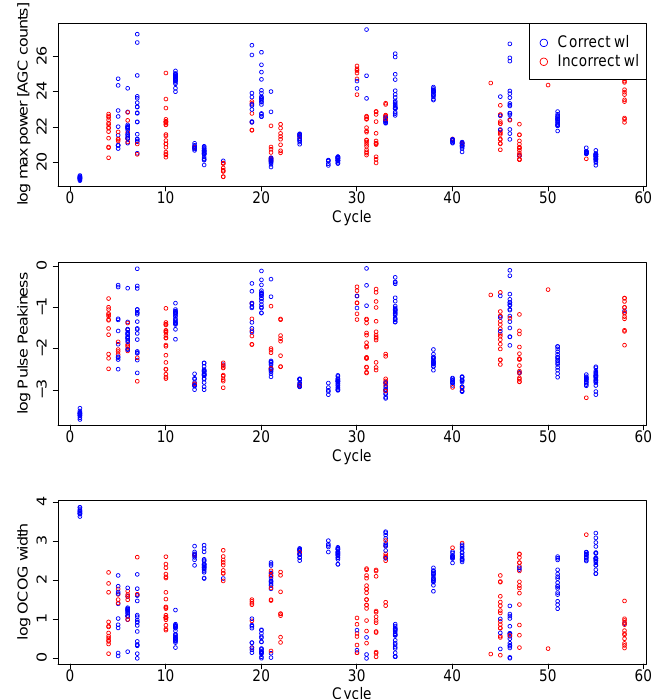
Figure A4. Waveform parameters; maximum power, pulse peakiness, and OCOG width as a function cycle for Lake Kiskittogisu track number 317. Measurements are displayed in blue if the surface elevation agrees with in situ data and in red if not.